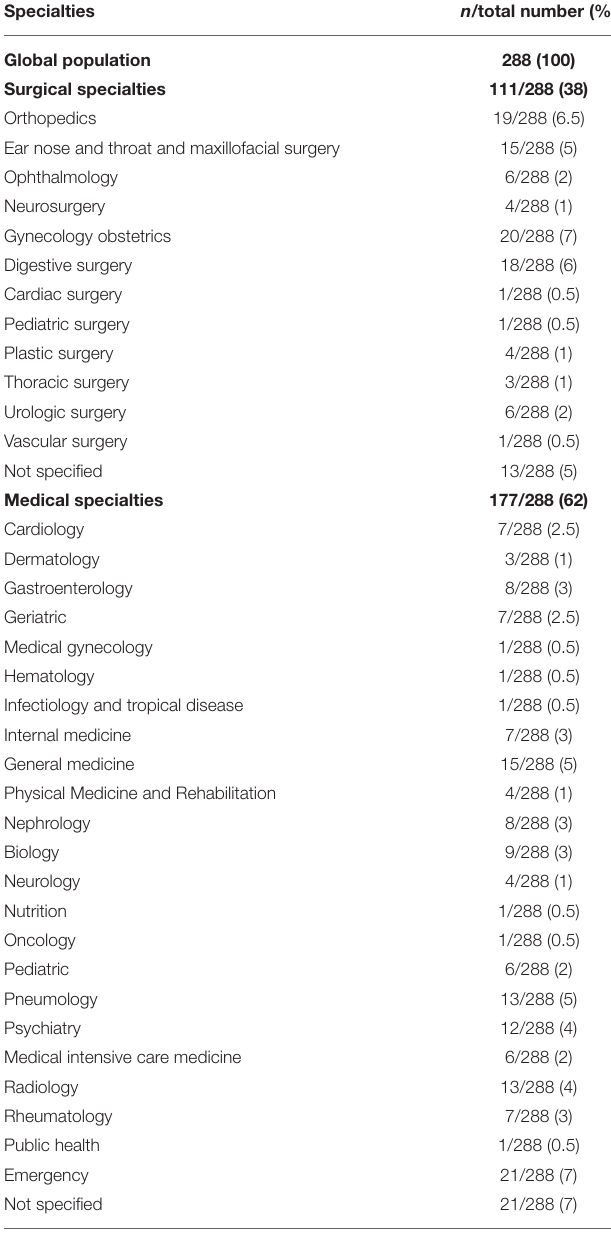
TABLE 2 | Repartition of the surgical and medical specialties. Specialties